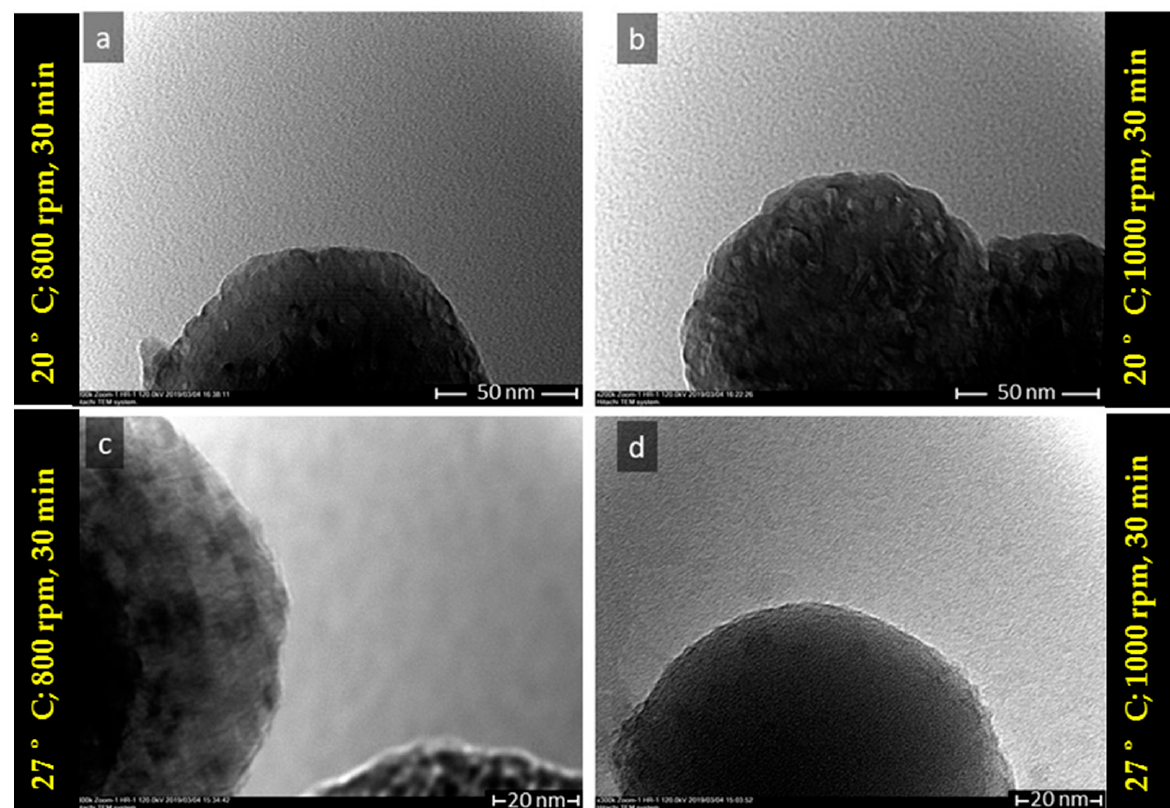
Figure 8. TEM images of vaterite synthesized at ( a ) T = 20 ◦ C, 800 rpm, ( b ) T = 20 ◦ C, 1000 rpm, ( c ) T = 27 ◦ C, 800 rpm, and ( d ) T = 27 ◦ C, 1000 rpm (reaction time 30 min). Table 6. Effect of temperature (20 °C, 27 °C) and stirring speed (800 rpm, 1000 rpm) on the specific